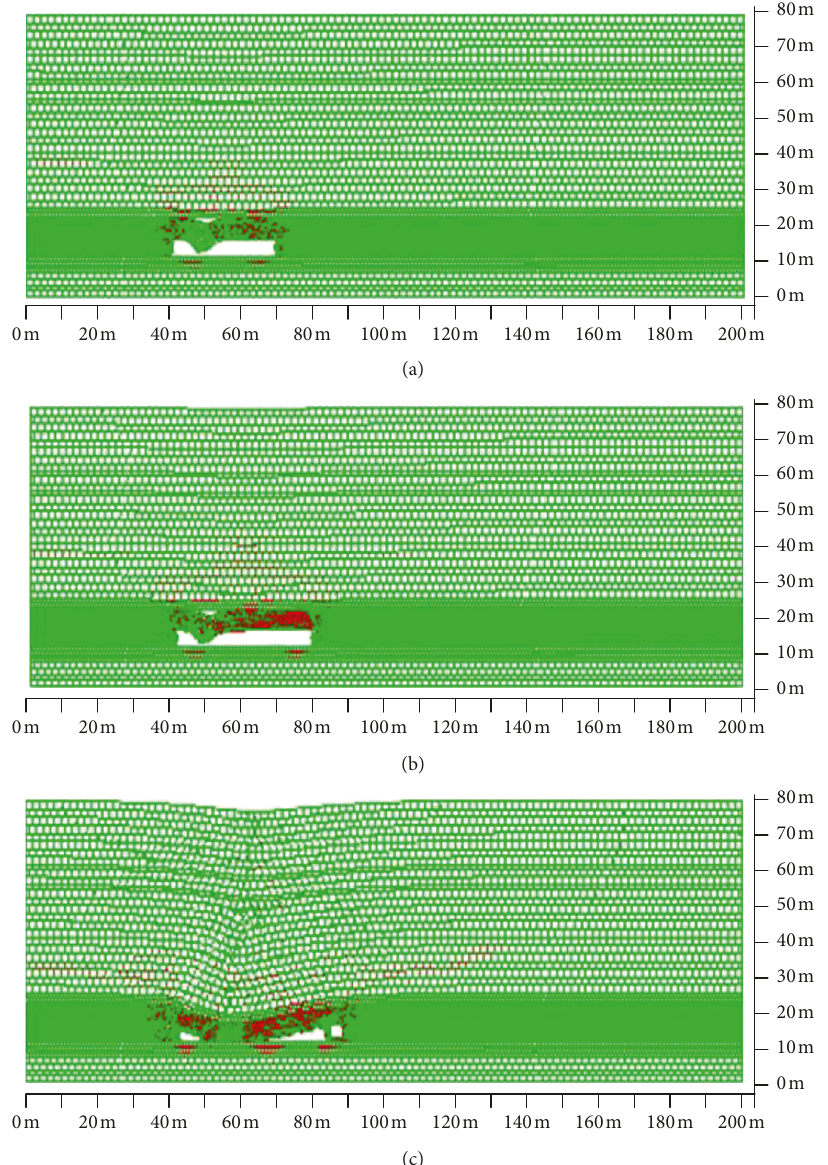
Figure 3: Movement law of the overburden strata when only one hard rock exists: advancing distances of the working face are (a) 30m, (b) 40m, and (c)